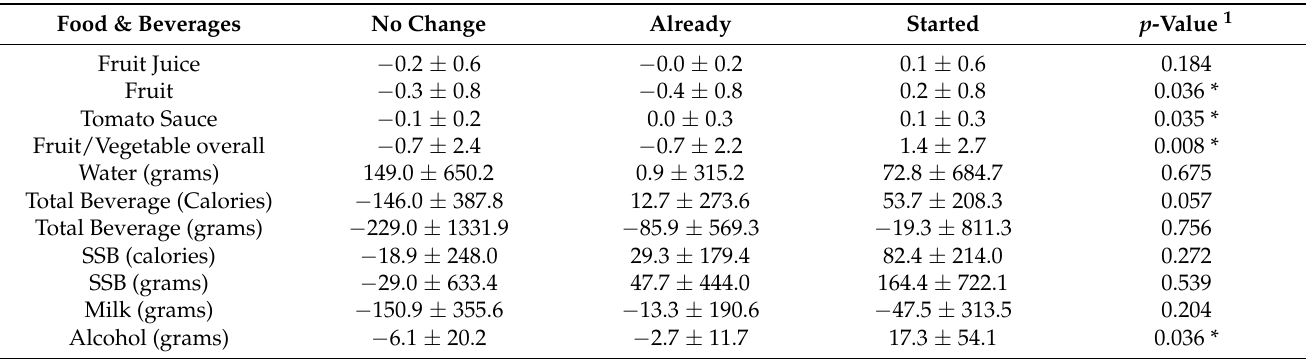
Table 3. Food and beverage dietary intake changes from time point one to time point two among cohort sample that reported changing venues to grocery